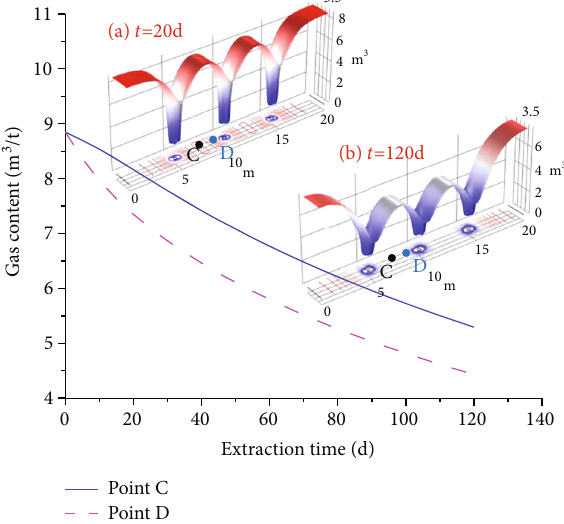
Figure 14: Variation of gas content with time when borehole diameter is 133mm.